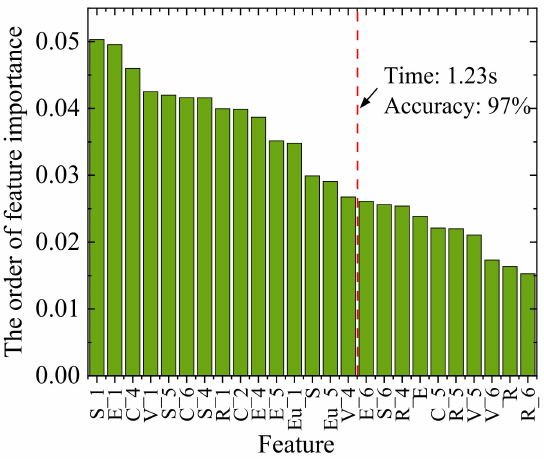
Figure 13. The order of feature importance.